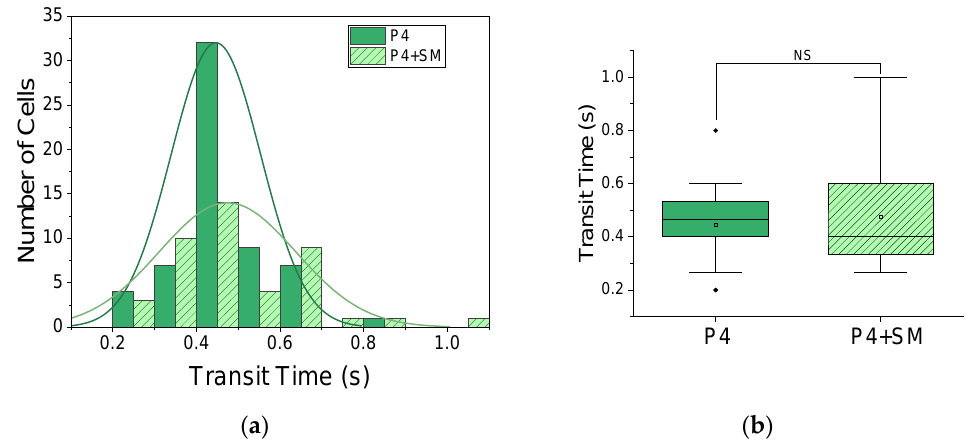
Figure 7. Non-significant change in transit time following induced hypoxia. ( a ) Histogram distribution for patient 4 (P4, n = 60) and patient 4 treated with SM (P4 + SM, n = 43). ( b ) Box plot of two-sample t-test, showing significant non-significant (NS) change in transit time from 0.45 ± 0.01 s for P4 to 0.47 ± 0.02 s for P4 + SM .